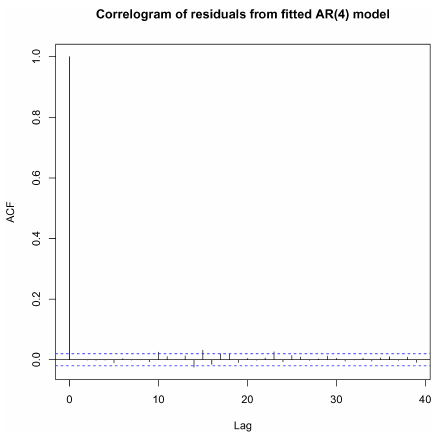
Fig. 9. Correlogram of the residuals of the fitted AR(4) model.